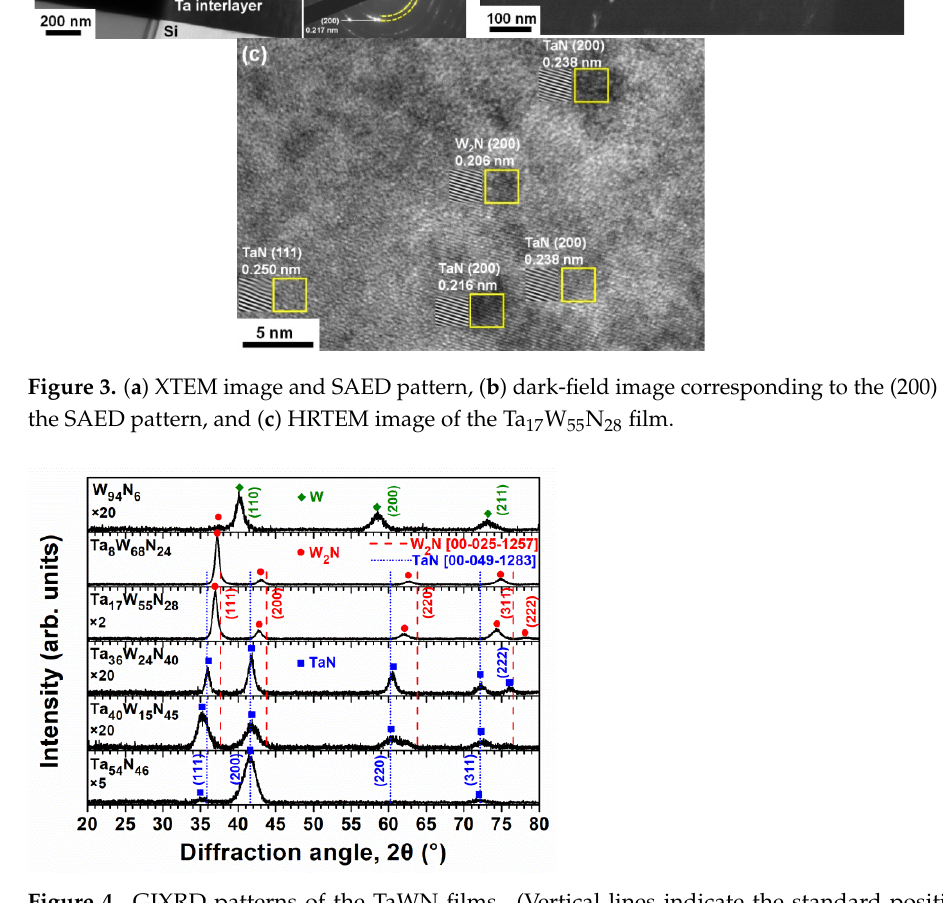
Figure 5. Lattice constants of the TaWN films. 3.2. Chemical Bonding Figure 6 displays the XPS analyses of TaWN films at a depth of 49.8 nm. Ta 4 f , W 4 f , and N 1 s signals were recorded. The aforementioned formation enthalpy for TaN and W 2 N at 298 K implied that TaN should have formed first, followed by W 2 N. Because all of the TaWN films were N-deficient, the Ta signals comprised two 4 f doublets contributed by Ta–N bonds in Ta 2 N and TaN. The intensity ratios of Ta–N bonds of Ta 2 N to that of TaN ( I Ta2N : I TaN ) were in the range of 24:76 to 33:67, as shown in Table 2. Table 2 lists the XPS analysis results obtained for the TaWN films at depths of 16.6, 24.9, 33.2, 41.5 and 49.8 nm. The binding energy values of Ta 4 f 7/2 for the Ta–N bonds in Ta 2 N and TaN compounds in the aforementioned TaWN films were 22.47–22.75 and 23.07–23.32 eV, respectively, which were comparable to the reported binding energies of Ta 4 f 7/2 of 22.3–22.9 eV [44–47] for Ta–N bonds in Ta 2 N and Ta 4 f 7/2 of 23.0–23.7 eV [44–48] for Ta–N bonds in TaN, re- spectively. The Ta 4 f 7/2 value for Ta–Ta bonds in pure Ta was 21.7–21.9 eV in the literature [44,45,47], which was not observed in this study. The 4 f 7/2 levels for pure Ta and W were 21.9 and 31.4 eV [37], respectively, and the standard values for 4 f doublets were marked in Figure 6 for comparison. The W signals comprised W–W and W–N 4 f doublets and a minor W–W 5 p 3/2 component and W–W bonds were the major forms of bonding. The in- tensity ratio I W–W : I W–N was higher than 68:32 for all the W-contained films. The low inten- sity of W–N bonds indicated the low affinity between W and N atoms. The binding energy values of W 4 f 7/2 for the W–W and W–N bonds in the fabricated TaWN films were 31.17– 31.44 and 32.27–33.05 eV, respectively, which were comparable to the reported 31.2–31.7 eV for W films and 32.1–33.1 eV for W–N bonds [49–52]. The N 1 s signals comprised N–